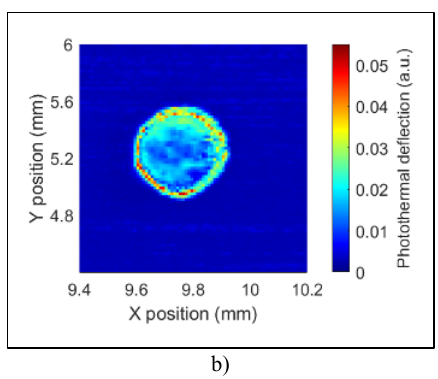
Fig. 4. Example of a a) transmission and b) PTD mapping over a LIDT site in Ta 2 O 5 coated fused silica sample. Scanning area (800 µm) 2 , scanning step 10 µm, PSD gain 1, and average pump power 18 mW.